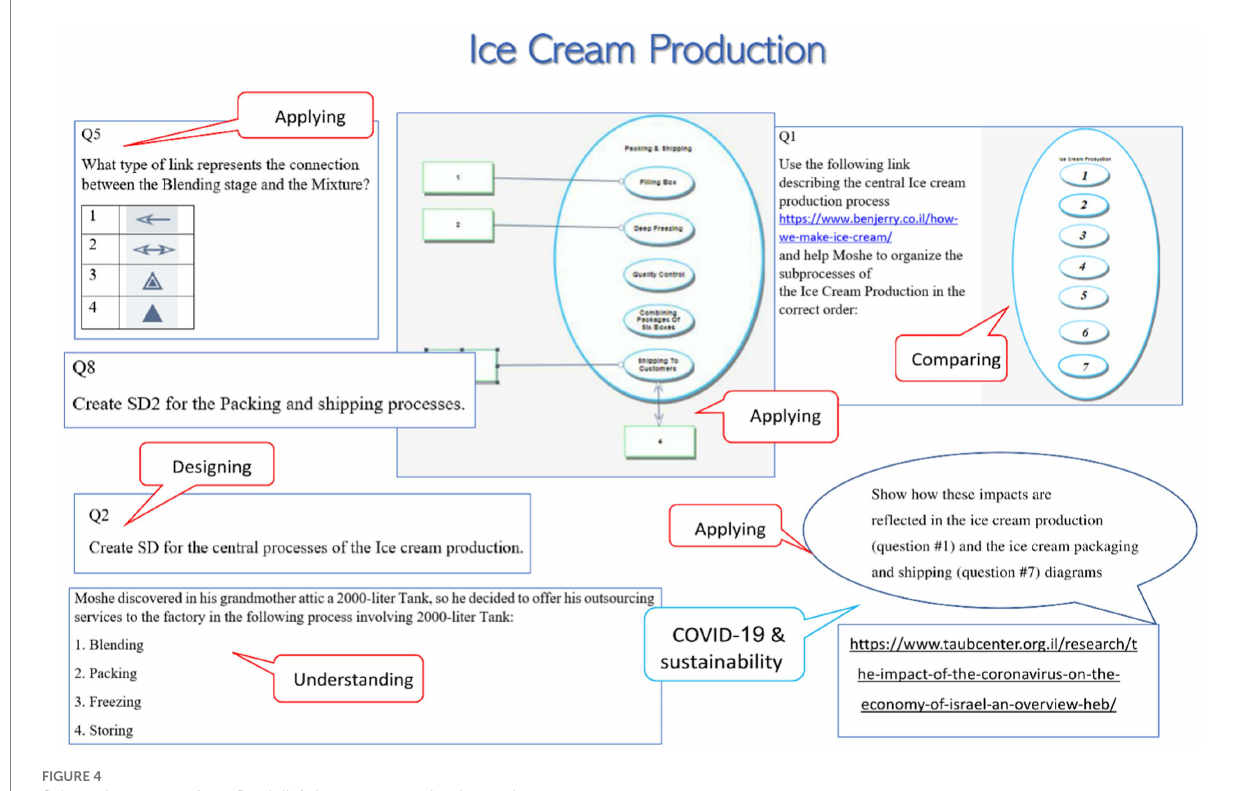
FIGURE 4 Selected segments from Danielle’s ice cream production